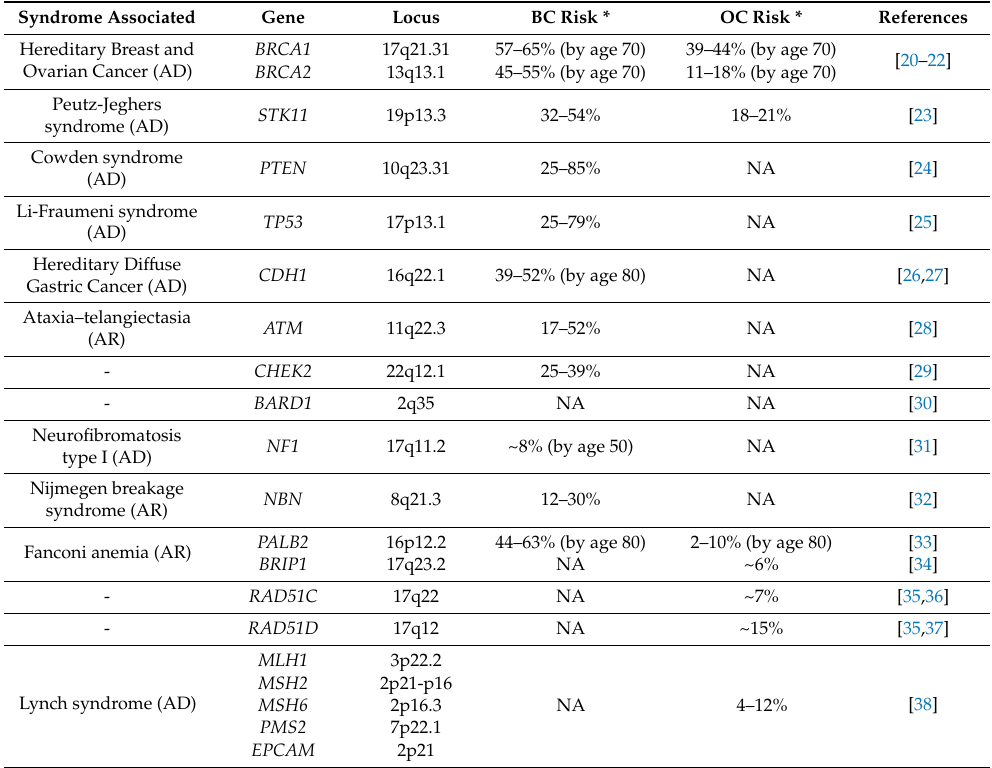
Table 1. List of the main genes associated with breast cancer (BC) / ovarian cancer (OC) with associated syndromes and BC / OC risk